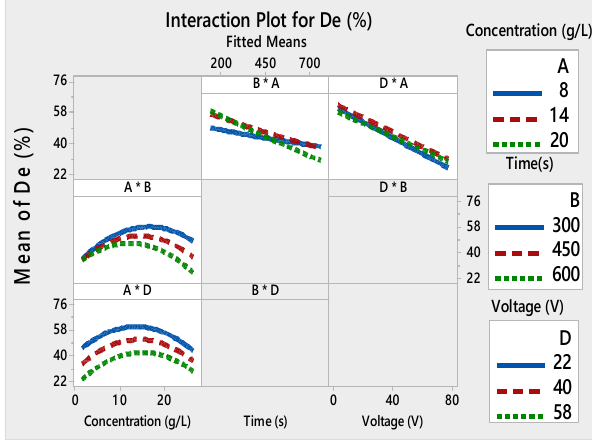
Figure 6. Interaction plots for L C3 ((*) refers to multiplication sign (×)).